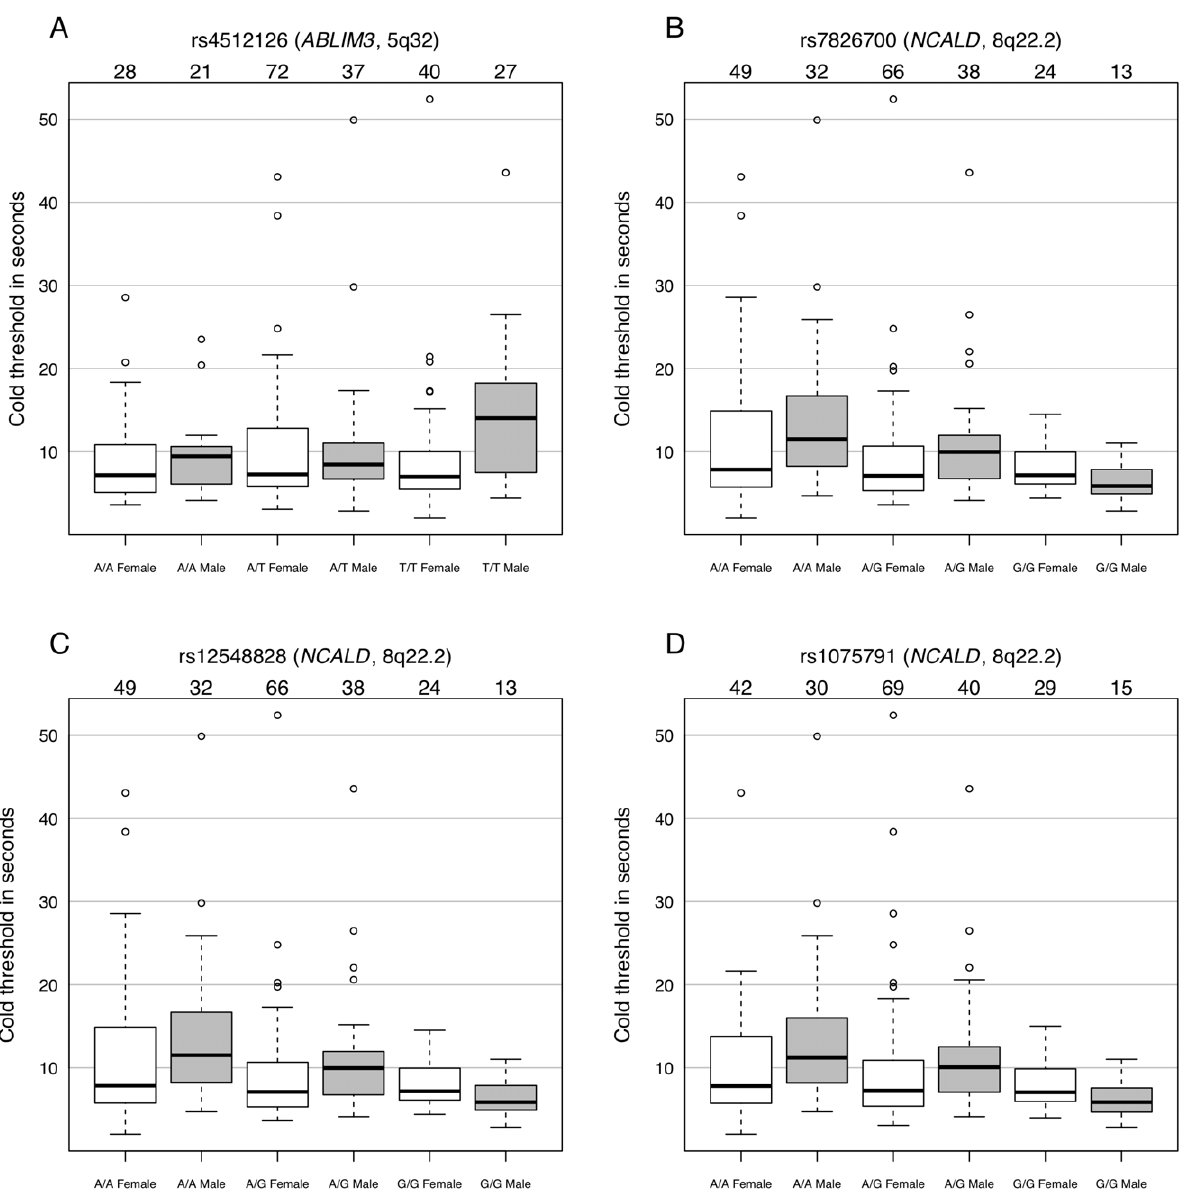
Figure 4. Boxplots of pain cold threshold by genotype and sex for polymorphisms found to be significantly associated with cold pressor pain. Dark lines within boxplots indicate the median. Box limits display first and third inter quartile. Horizontal lines at the limit of the boxplots represent the upper and lower end of the nominal data range defined as the upper quartile plus 1.5 times the inter quartile difference (IQD) and, the lower quartile minus 1.5 times the IQD, respectively. Open circles represent outliers falling outside the nominal data range. Numbers displayed above the boxplots indicate the number of individuals in the respective group.